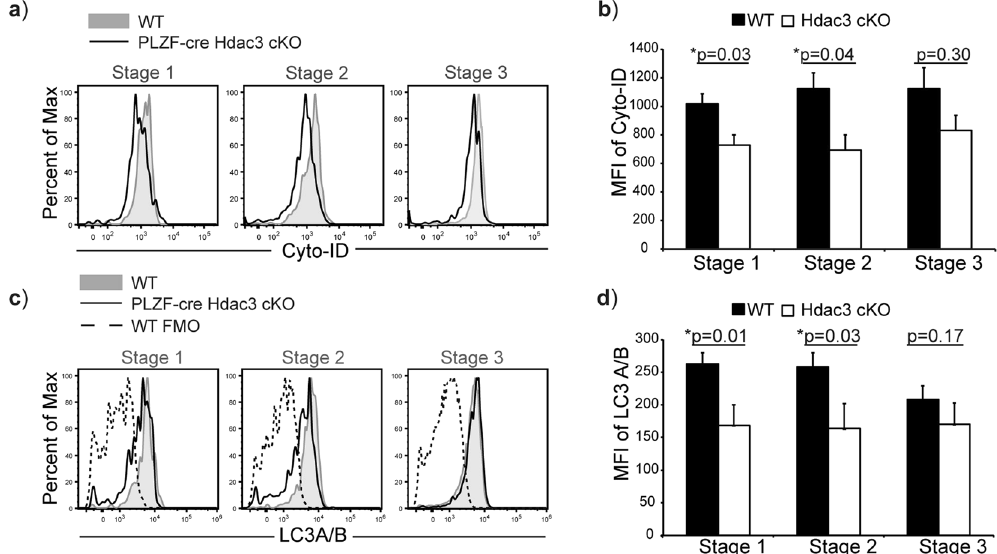
Figure 5. Hdac3-deficient iNKT cells exhibit reduced autophagy. ( a ) Overlay of expression of Cyto-ID stain in Stage 1–3 iNKT cells in WT (grey filled) and PLZF-cre Hdac3 cKO mice (black line). Data is representative of at least 5 WT and 4 PLZF-cre Hdac3 cKO mice from 3 independent experiments. ( b ) Quantification of average MFI of Cyto-ID intake by Stage 1–3 iNKT cells in WT (black bar) and PLZF-cre Hdac3 cKO (white bar) mice. Data is calculated from 5 WT and 4 PLZF-cre Hdac3 cKO mice from 3 independent experiments. Statistical analysis was done using student’s t test. Means ± SEM. ( c ) Examination of total LC3A/B in Stage 1–3 iNKT cells from WT (grey filled) and PLZF-cre Hdac3 cKO (black line) mice. For the LC3A/B stain, WT fluorescence minus one (FMO) is shown as a control. Data is representative of at least 5 WT and 4 PLZF-cre Hdac3 cKO mice from 3 independent experiments. ( d ) Quantification of average MFI of LC3A/B expression by Stage 1–3 iNKT cells in WT (black bars) and PLZF-cre Hdac3 cKO (white bars) mice. Data is calculated from 5 WT and 4 PLZF-cre Hdac3 cKO mice from 3 independent experiments. Statistical analysis was done using student’s t test. Means ±